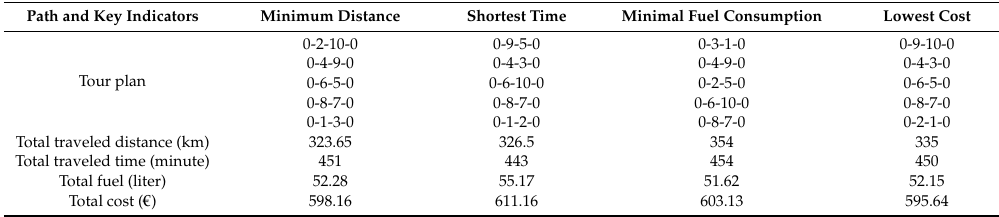
Table 4. Scenarios of 11 nodes with di ff erent objective functions when K = A.